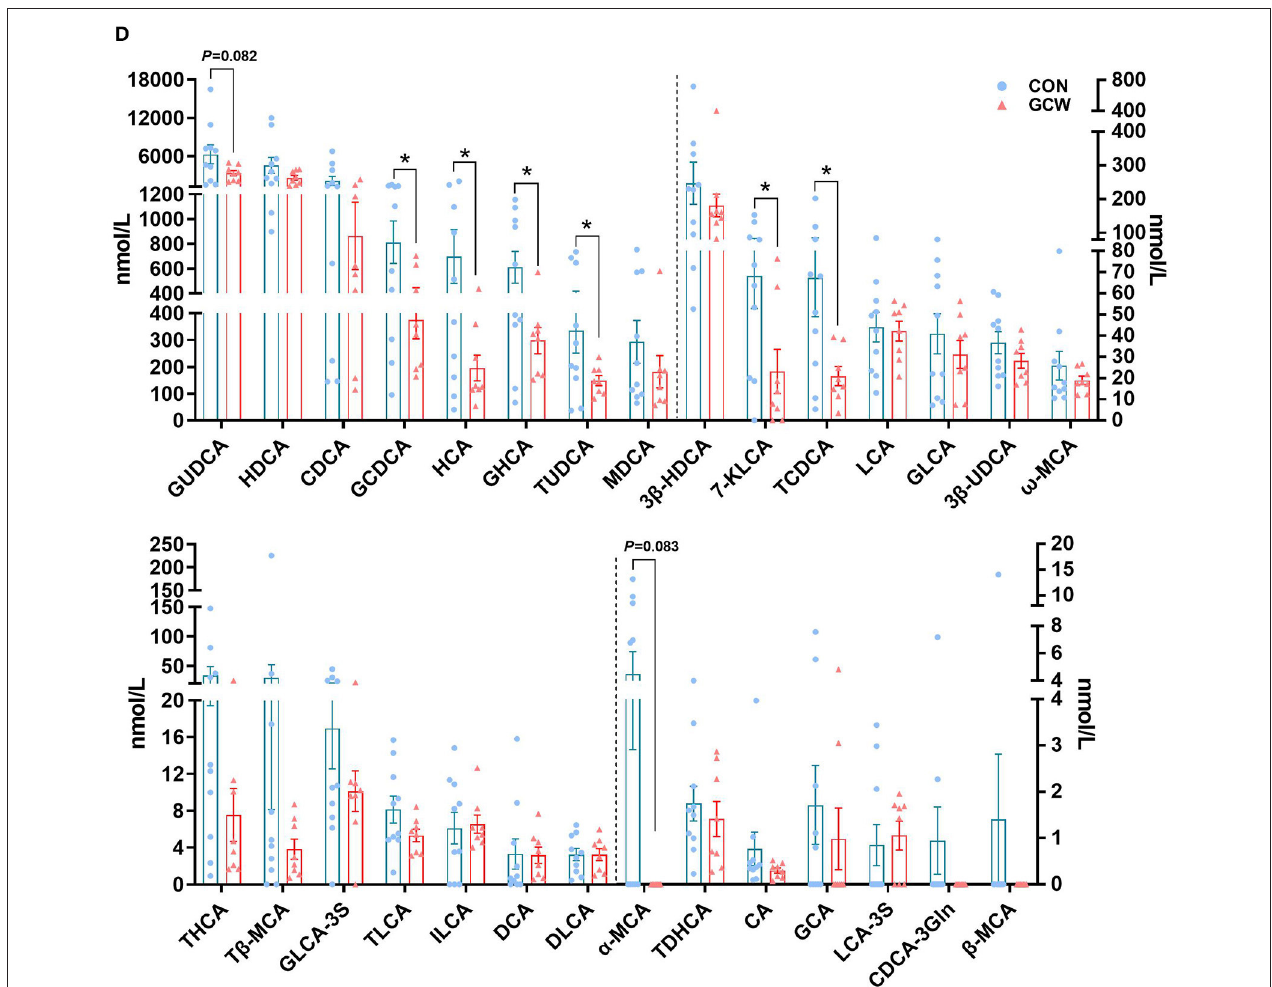
FIGURE 4 | Plasma bile acid composition between the two groups at day 90 and day 109 of gestation. Plasma total bile acids, total unconjugated bile acids, total glycine-conjugated, and total taurine-conjugated bile acids at day 90 (A) and day 109 (B) of gestation. Plasma individual bile acids at day 90 (C) and day 109 (D) of gestation. Data are presented as means ± SEM ( n = 8–10/group). * p < 0.05, ** p <